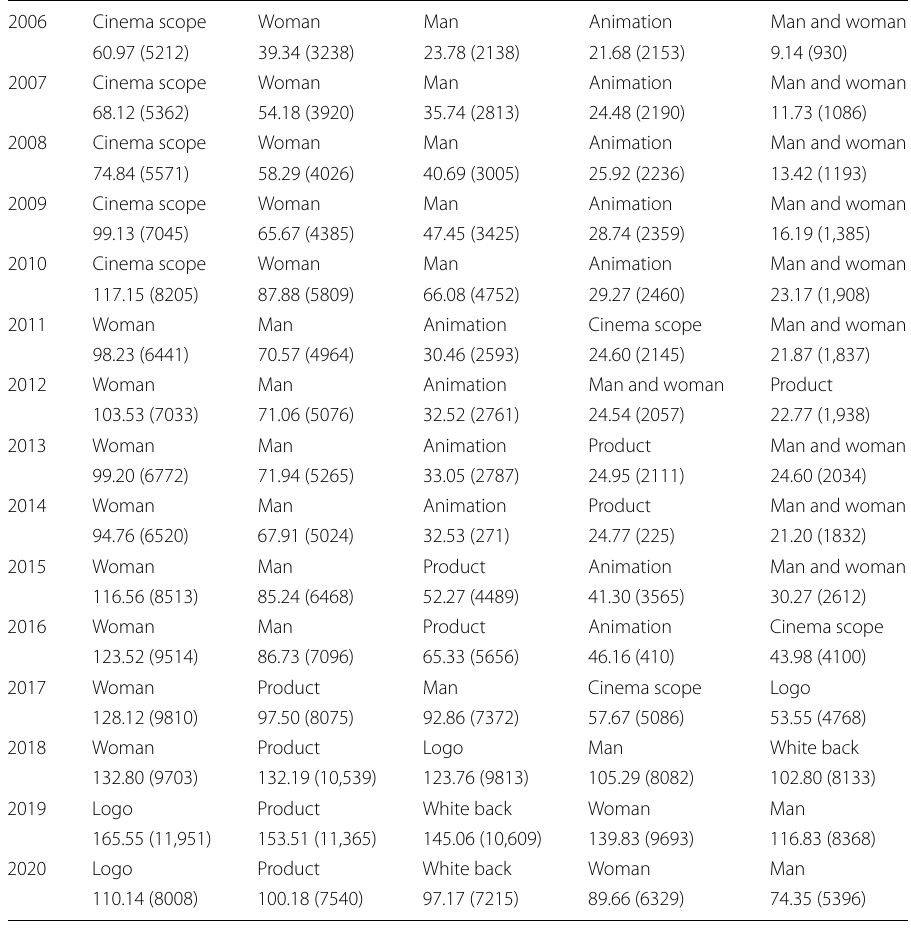
The degree of each node is also shown in